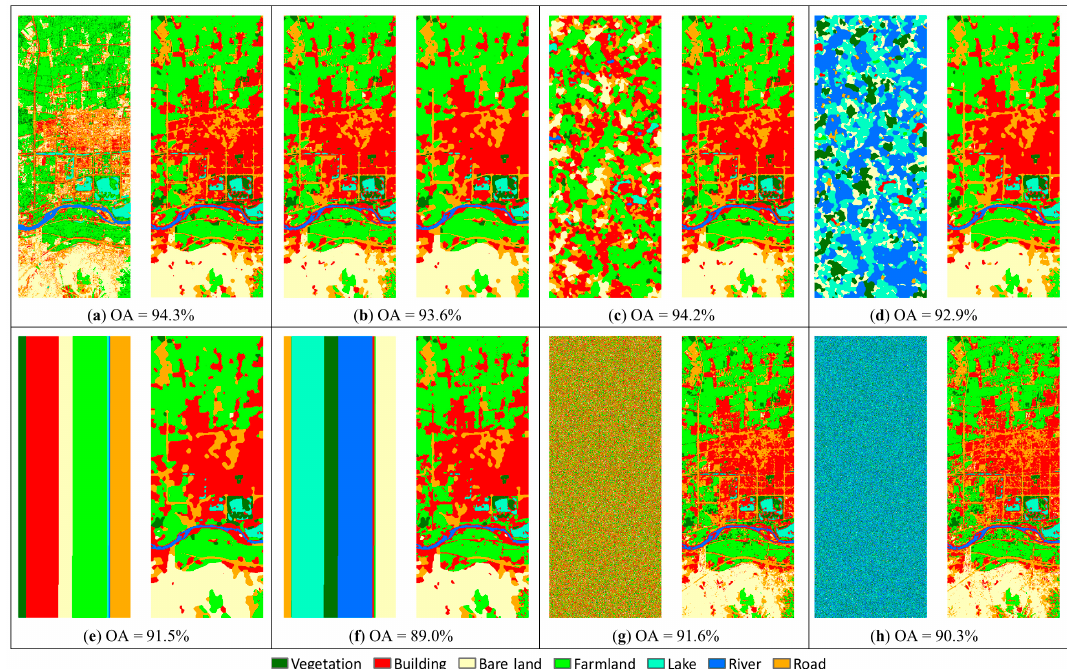
Figure 12. Classification results using the MLC-MIX-E method for the Landsat image based on different TIs. ( a ) The KNN classification result used as TI and the classification result, ( b ) the MLC-MIX-E classification result used as TI and the classification result, ( c ) the simulation image with the proper class proportions used as TI and the classification result, ( d ) the simulation image with the improper class proportions used as TI and the classification result, ( e ) the stripes pattern with the proper class proportions used as TI and the classification result, ( f ) the stripes pattern with the improper class proportions used as TI and the classification result, ( g ) the random noise pattern with the proper class proportions used as TI and the classification result, ( h ) the random noise pattern with the improper class proportions used as TI and the classification result.